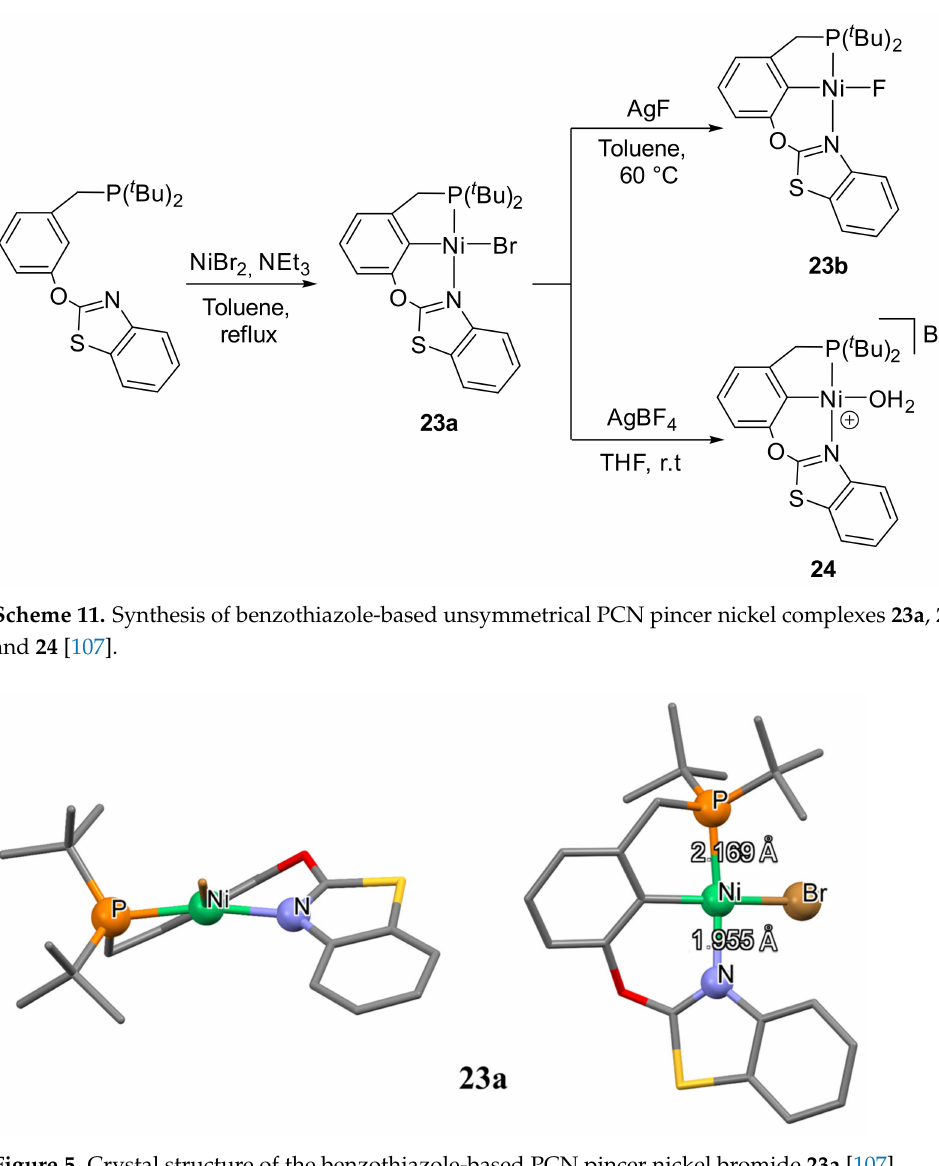
complex 23a . Fluoride analogue 23b was obtained by treatment of 23a with silver fluoride in toluene (Scheme 11). The ionic aquo complex 24 was synthesized through bromide abstraction from 23a with a silver tetrafluoroborate in THF. The water molecule came from the AgBF 4 or from THF. The N atom in the thiazole ring is a stronger donor, therefore